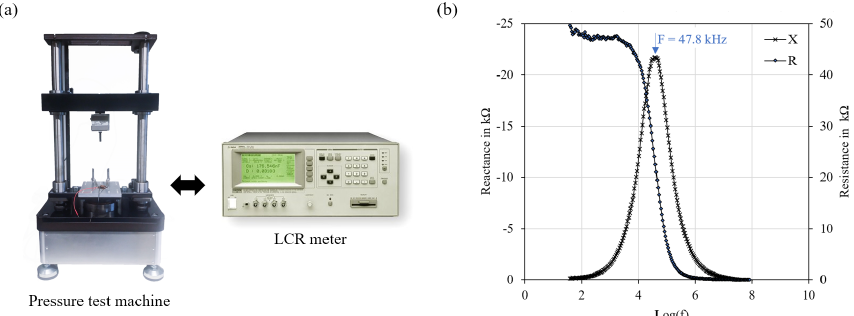
Figure 3. (a) The custom-built pressure test bench used to characterize the fabricated sensor. (b) Plot representing the resonance frequency of the sensor measured using an impedance analyzer.